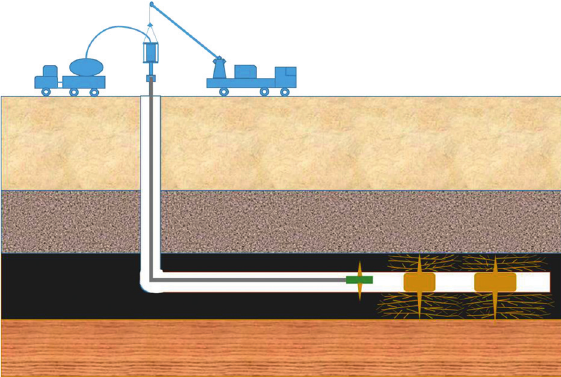
Figure 3: Schematic diagram of coiled tubing driven fracturing. Table 2: Fracturing parameters of the four cluster horizontal wells in the Libi